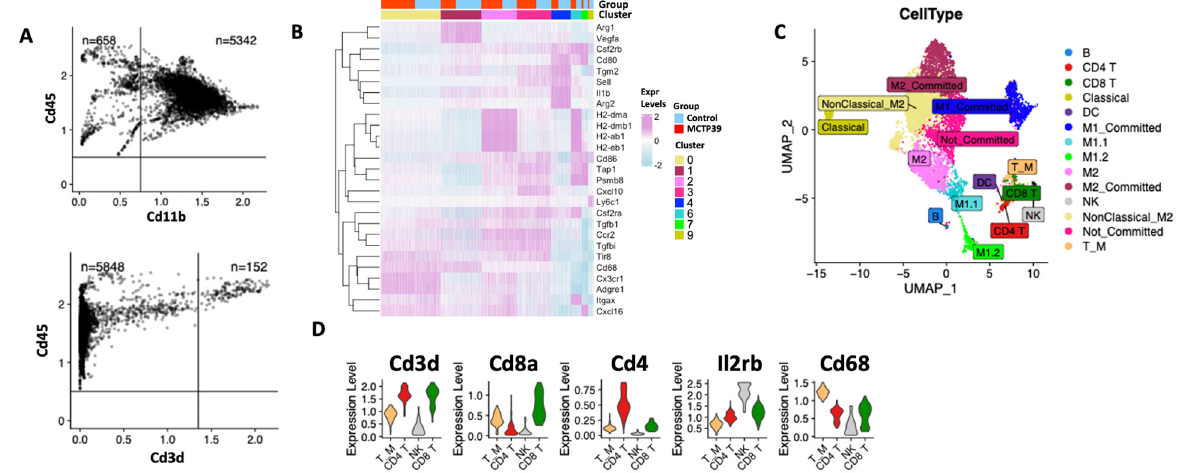
Figure 2. scRNASeq analysis of tumor-infiltrating immune cells. ( A ) Exploratory scatter plot showing the proportions of CD45 + CD11b + myeloid cells (top) and CD45 + CD3 + lymphocytes (bottom) in the samples used for scRNASeq. ( B ) Expression pattens for the panel of genes used to classify myeloid cells. Purple and light blue cells indicate high and low expression, respectively. The annotation on top indicates the cluster assignments and the group (control, MCTP39). ( C ) UMAP representation of the final annotation for all the cell types identified. ( D ) Violin plots showing the expression of markers used to classify CD8 + , CD4 + , NK, and T_M cells.